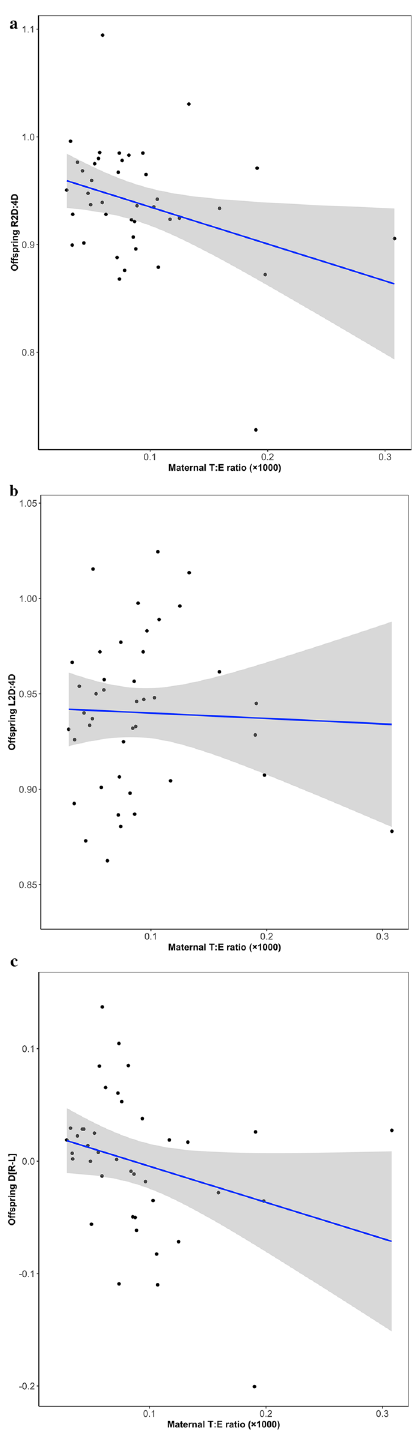
Figure 1. Scatterplots showing the associations between maternal T:E ratio and children’s ( a ) R2D:4D, ( b ) L2D:4D, and ( c ) D [R−L] . Raw data (not controlled for covariates) are shown; T:E ratio is multiplied by